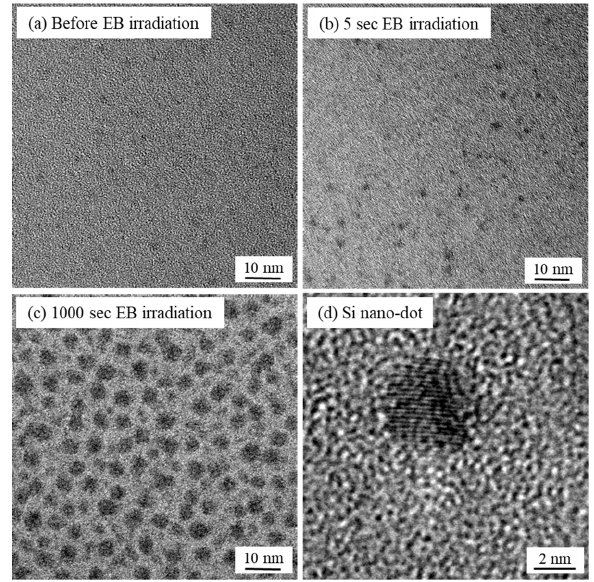
Figure 8. TEM images of SiO 2 films after EB irradiation for ( a ) 0 s, ( b ) 5 s, ( c ) 1000 s, and ( d ) Enlarged view of an Si nanodot.